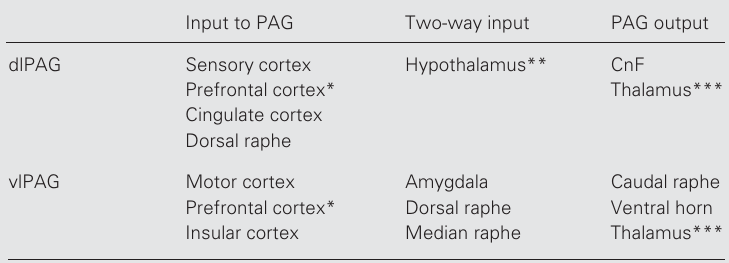
Table 1. Main connections between central nervous system structures and periaque- ductal